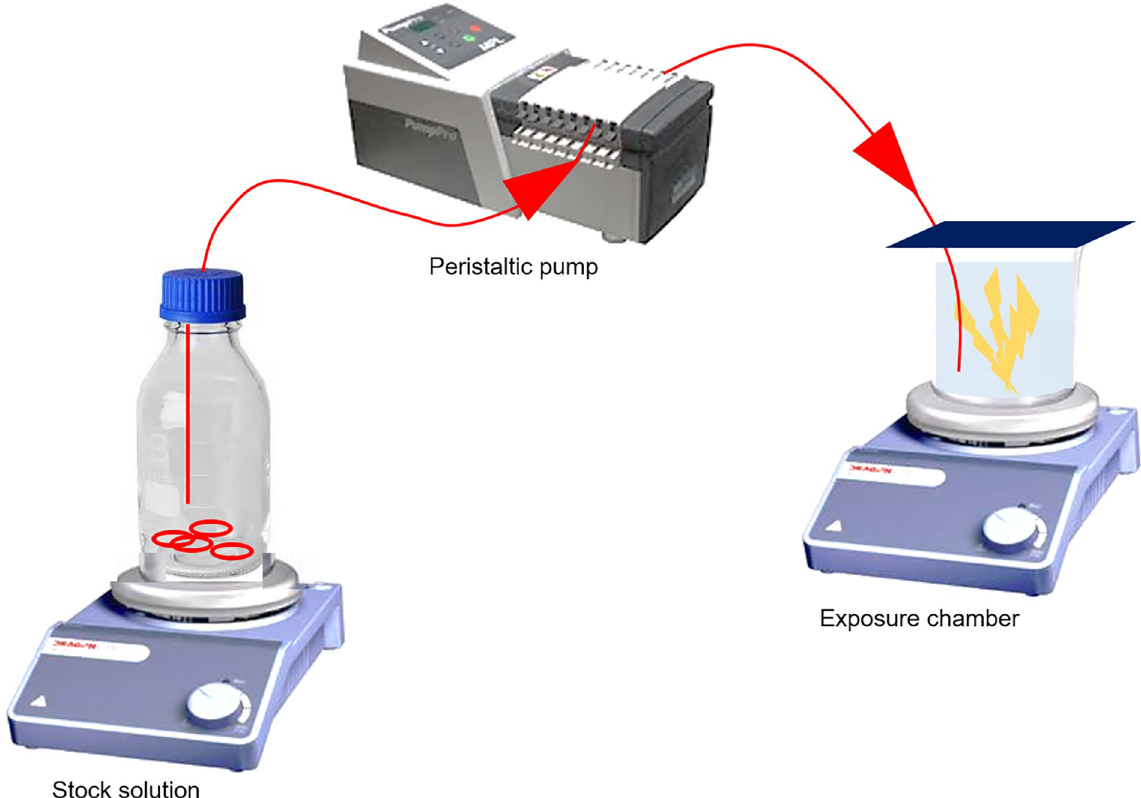
Fig 1. Setup for 2-methylnaphthalene exposure. Based on the principles of passive dosing described by Butler et al. [32], a passive dosage open system with flow-through using silicone O-rings has been developed. The peristaltic pump transfers stock solution from the stock bottle to the exposure chamber containing the test